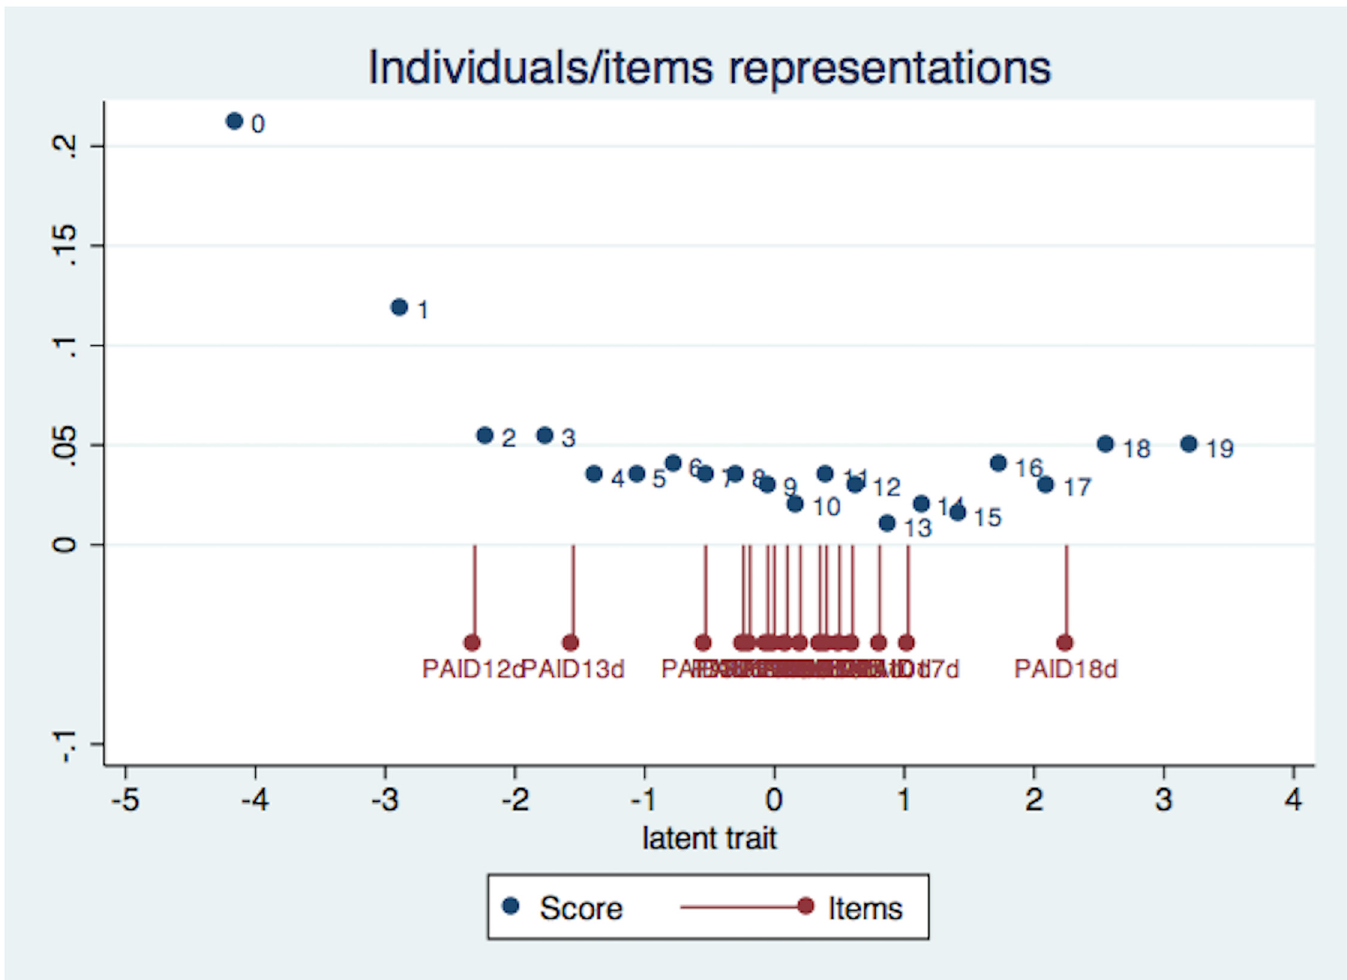
Fig 1. Item-person map illustrating the distribution of item difficulty along the y-axis and person ability along the x-axis. doi:10.1371/journal.pone.0136759.g001 PLOS ONE | DOI:10.1371/journal.pone.0136759 September 3,